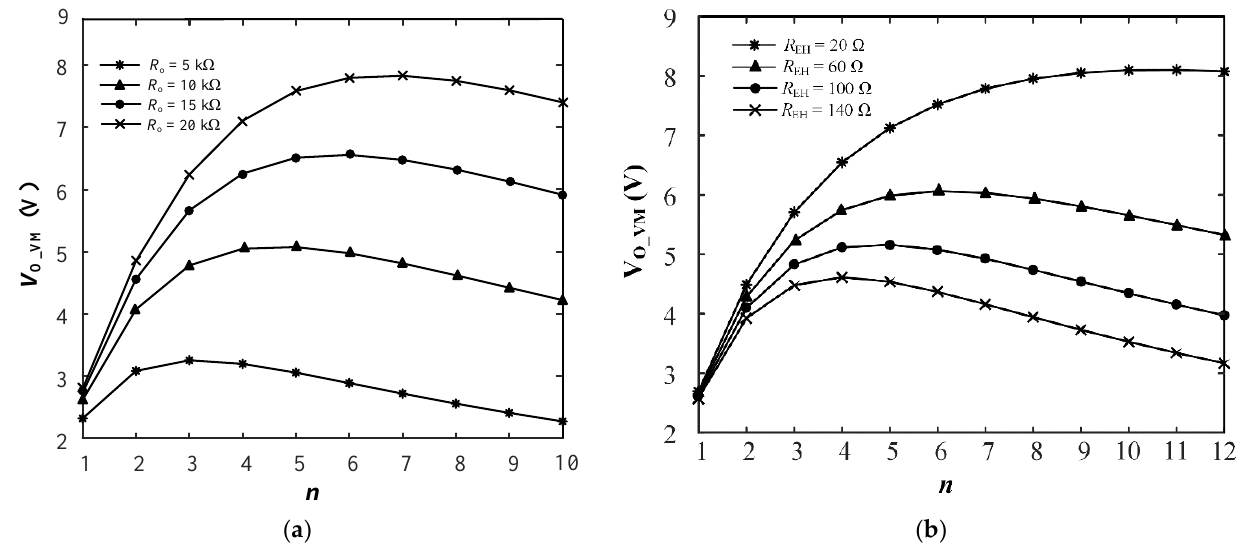
Figure 10. ( a ) The relationship of n and V O_VM at different load resistors with R EH = 100 Ω; ( b ) the relationship of n and V O_VM at different EH output resistors with R O = 10 kΩ.